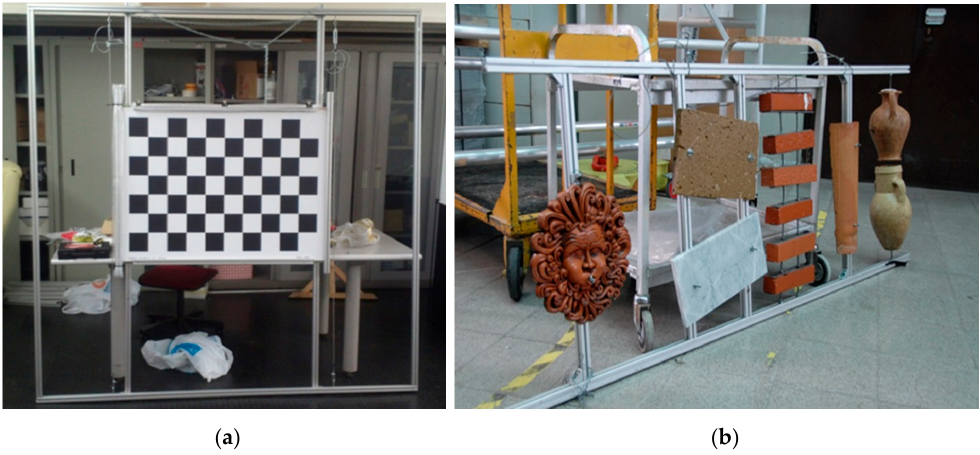
Figure 6. Orientation fixture ( a ). Target made of objects with different materials and shapes ( b ).